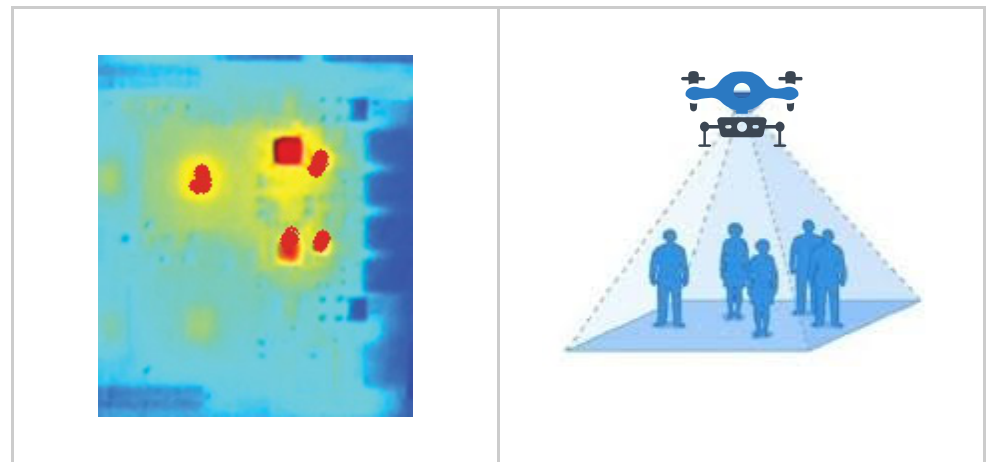
Figure 2. Example of thermal imaging system based on a temperature sensor array.